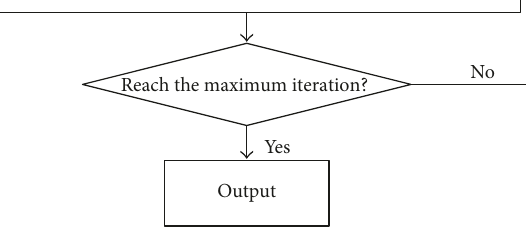
Figure 1: Flowchart of the proposed BAG-SA